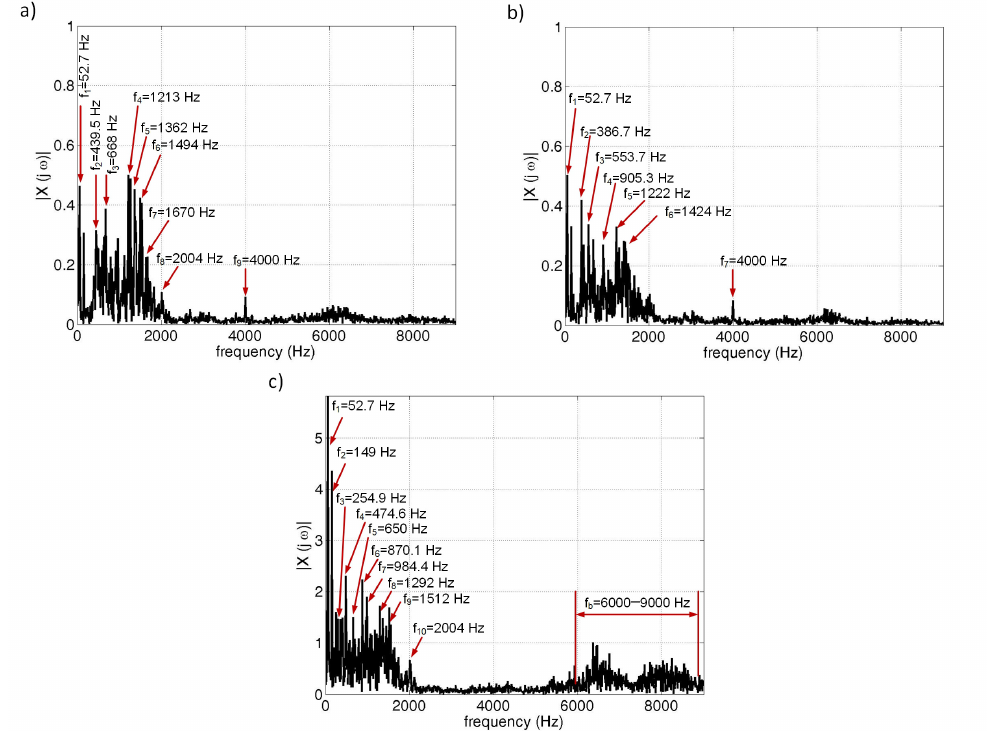
Figure 10. Detailed view of dominant frequencies in operational modes VII.–IX. (( a ) frequency amplitude spectrum of the vibration signal of three aggregates without drill bit, ( b ) the vibration signal of three aggregates without drill bit, ( c ) the andesite rock disintegrating vibration